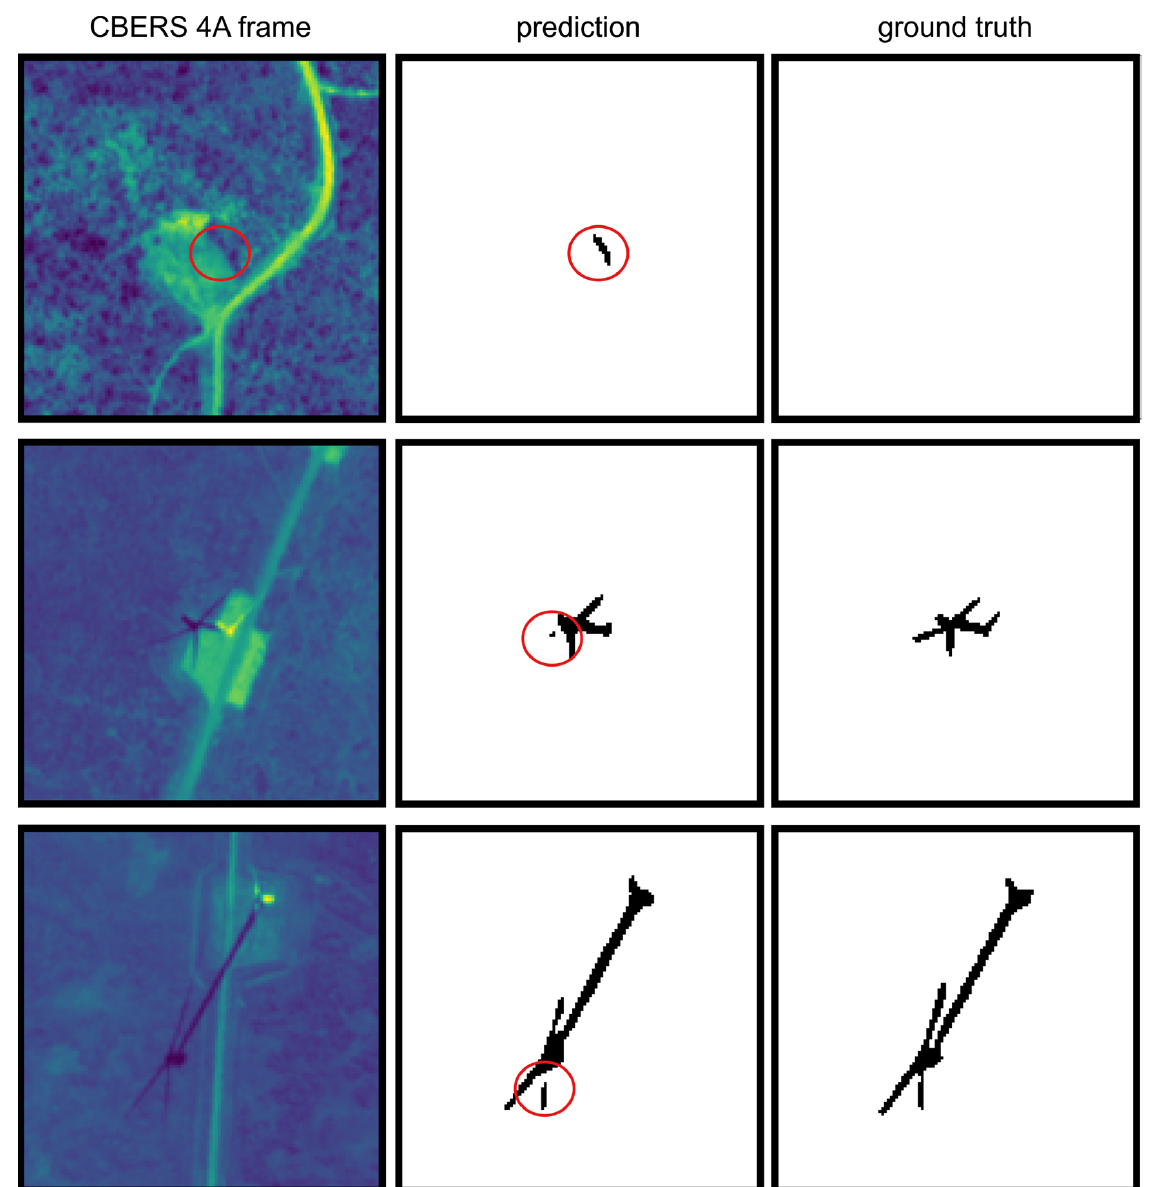
Figure 5. Image patches from the test set considering the original CBERS 4A image, ground truth, and deep learning prediction. The spots in red are highlighted areas that show in more detail the areas with errors.